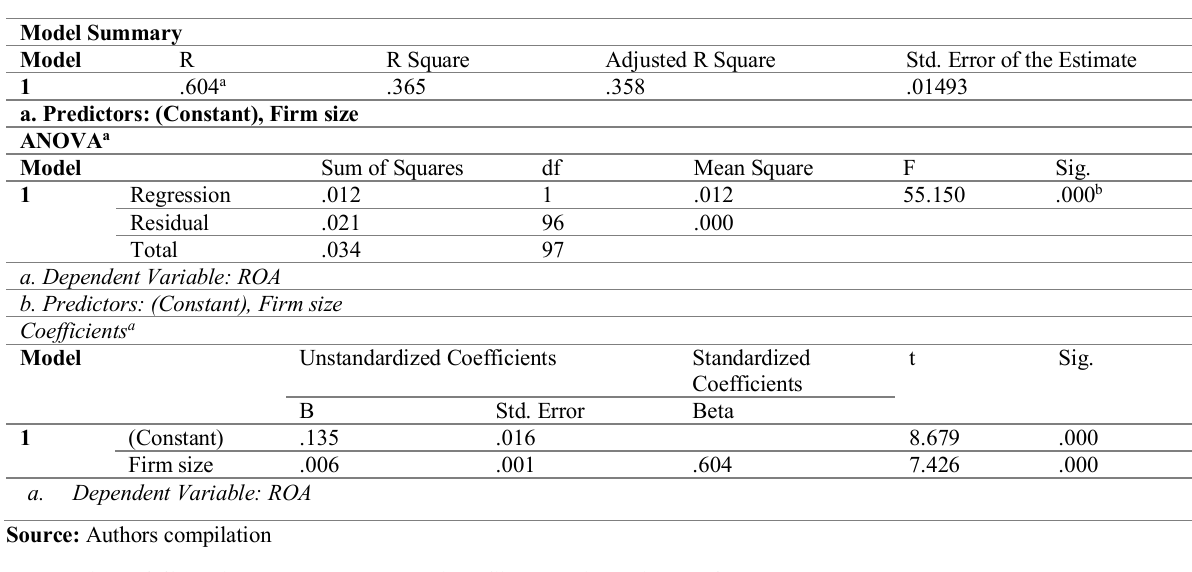
Table 9: Effect of Firm Size on Financial